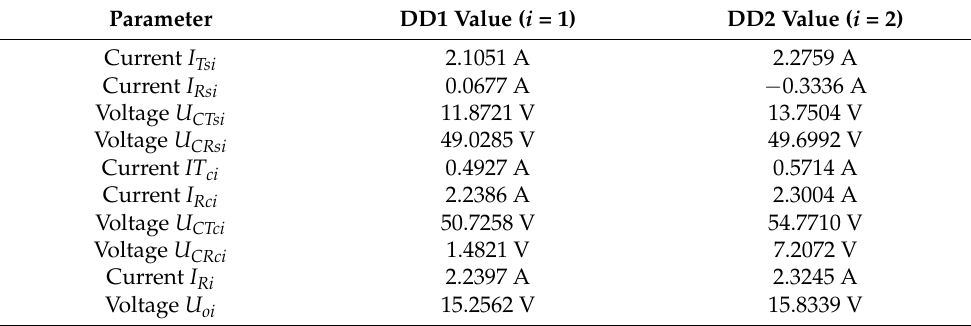
Table 3. Operating point of the double DD coil